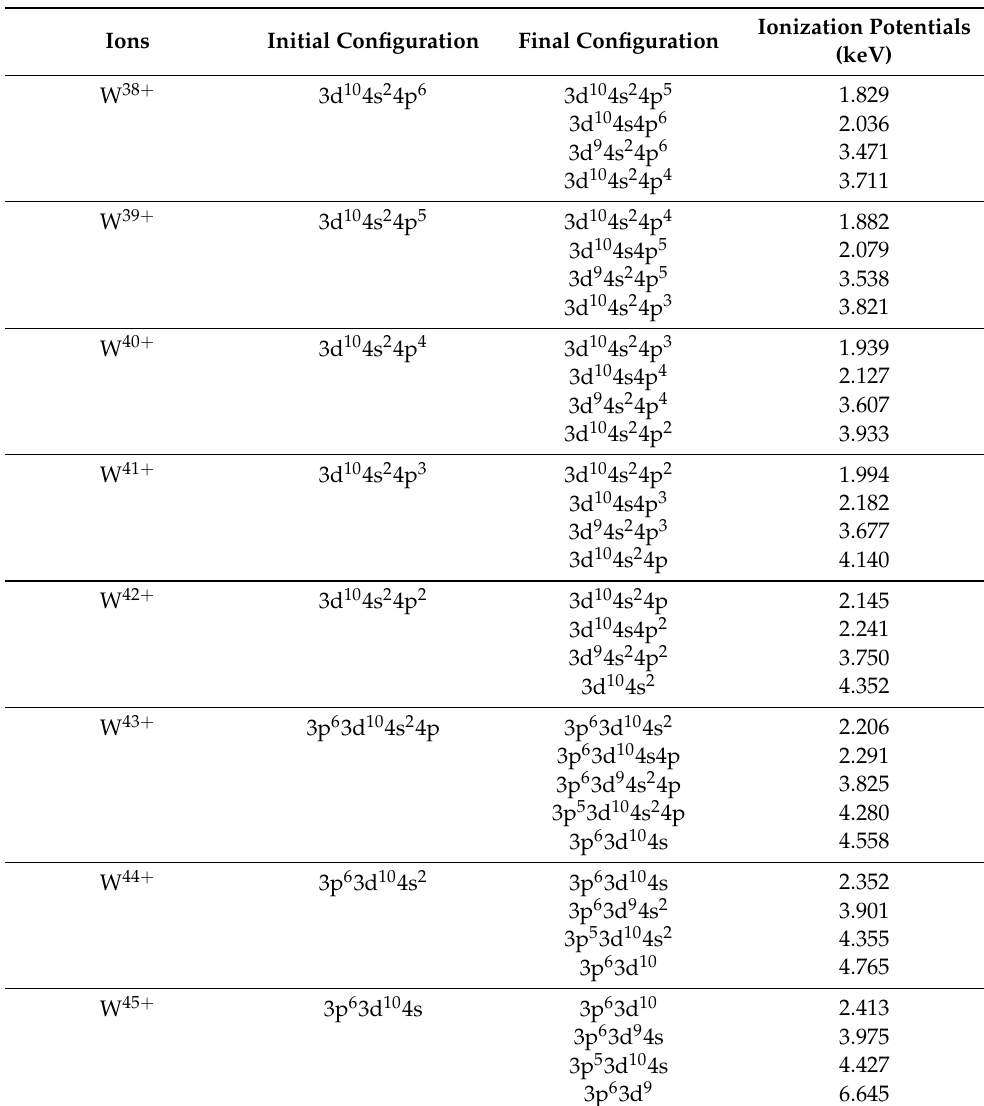
Table 3. Ionization potentials for W 38 + − W 45 +